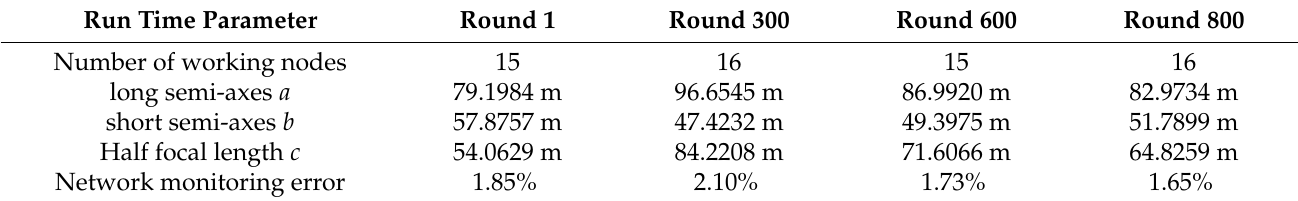
Table 2. Ellipse parameters and network monitoring